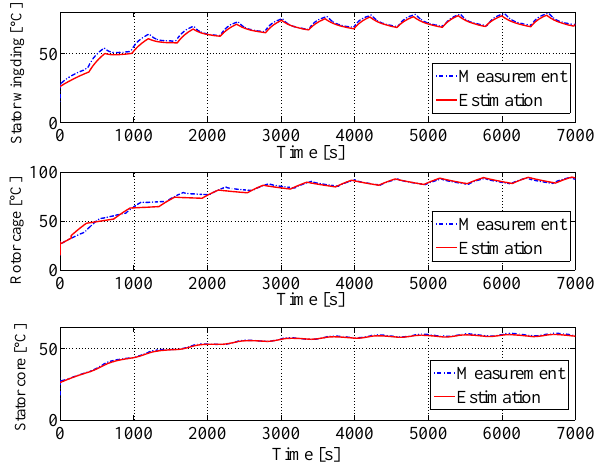
Figure 20. Comparison of measured and estimated temperatures under